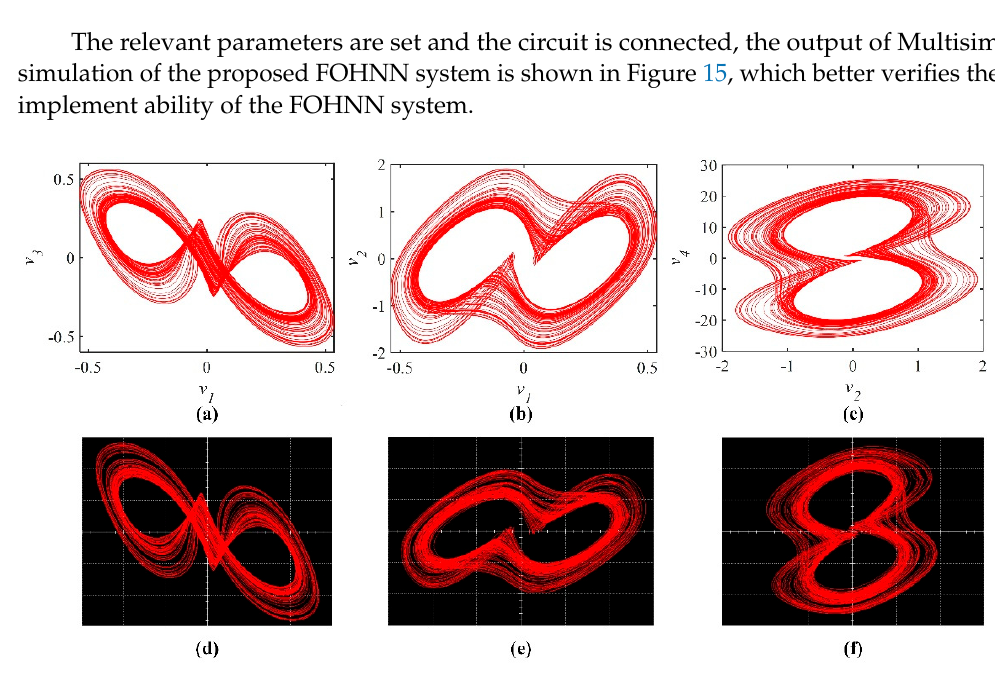
Figure 15. Results based on simulation platform ( a – c ) Simulation results based on Matlab platform. ( d – f ) Phase diagram of the Multisim simulation output of the FOHNN system.